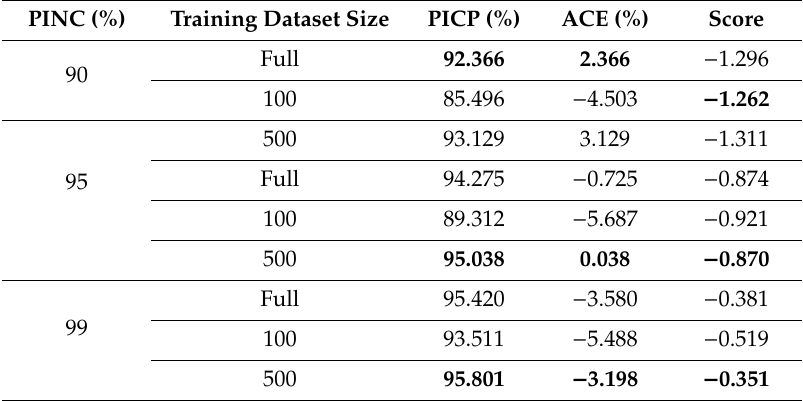
Table 5. Evaluation results of PIs in Y(2) prediction.